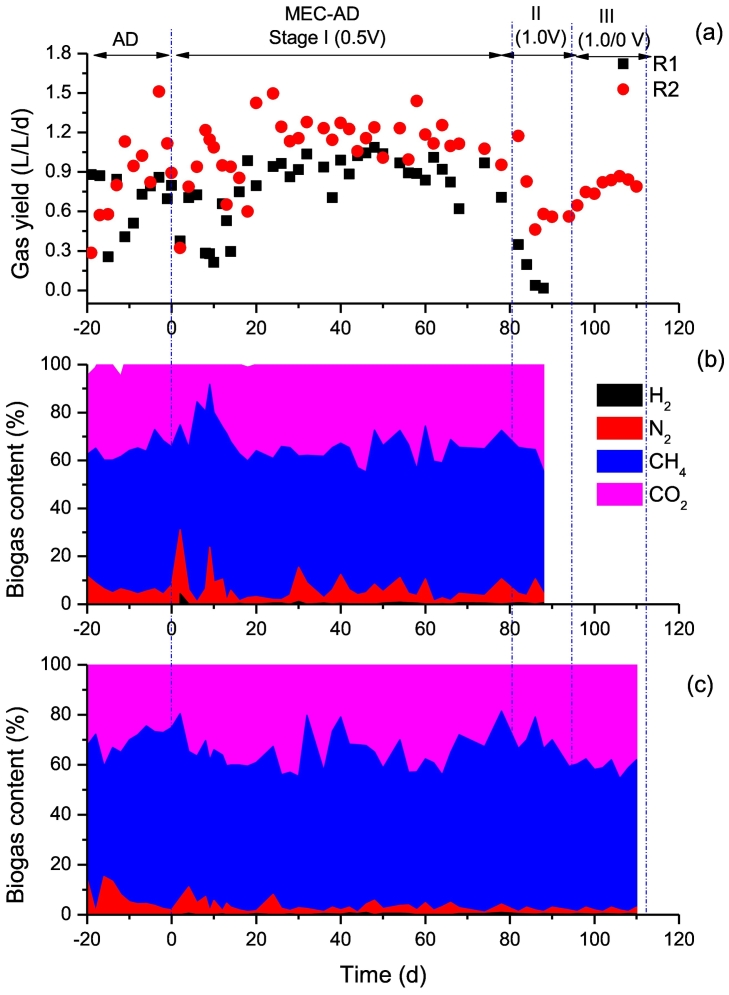
Variations of biogas generation during different stages: (a) volumetric gas yield, (b) biogas content from R1 and (c) biogas content from R2.